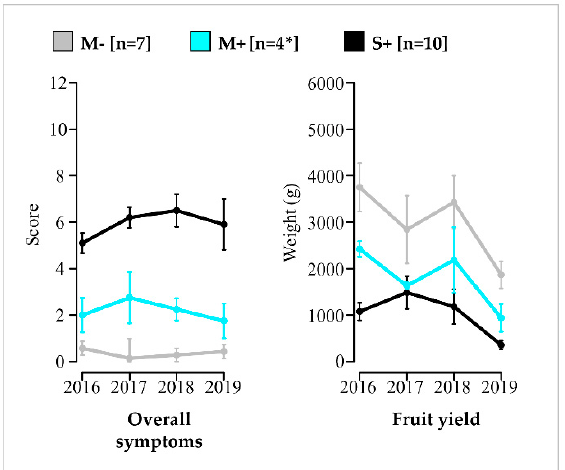
Figure 3. Evolution of yearly mean overall symptom scores and fruit yields of vines in the M − , M+ and S+ categories and their standard error. Results for vines in the M − (in grey), M+ (in cyan) and S+ (in black) categories are shown. Number of vines (n) is given in brackets. Means values are connected by bold lines and standard errors are materialized by vertical bars. * For the M+ category, only three vines were considered in June 2016 for the evaluation of the qualitative traits.